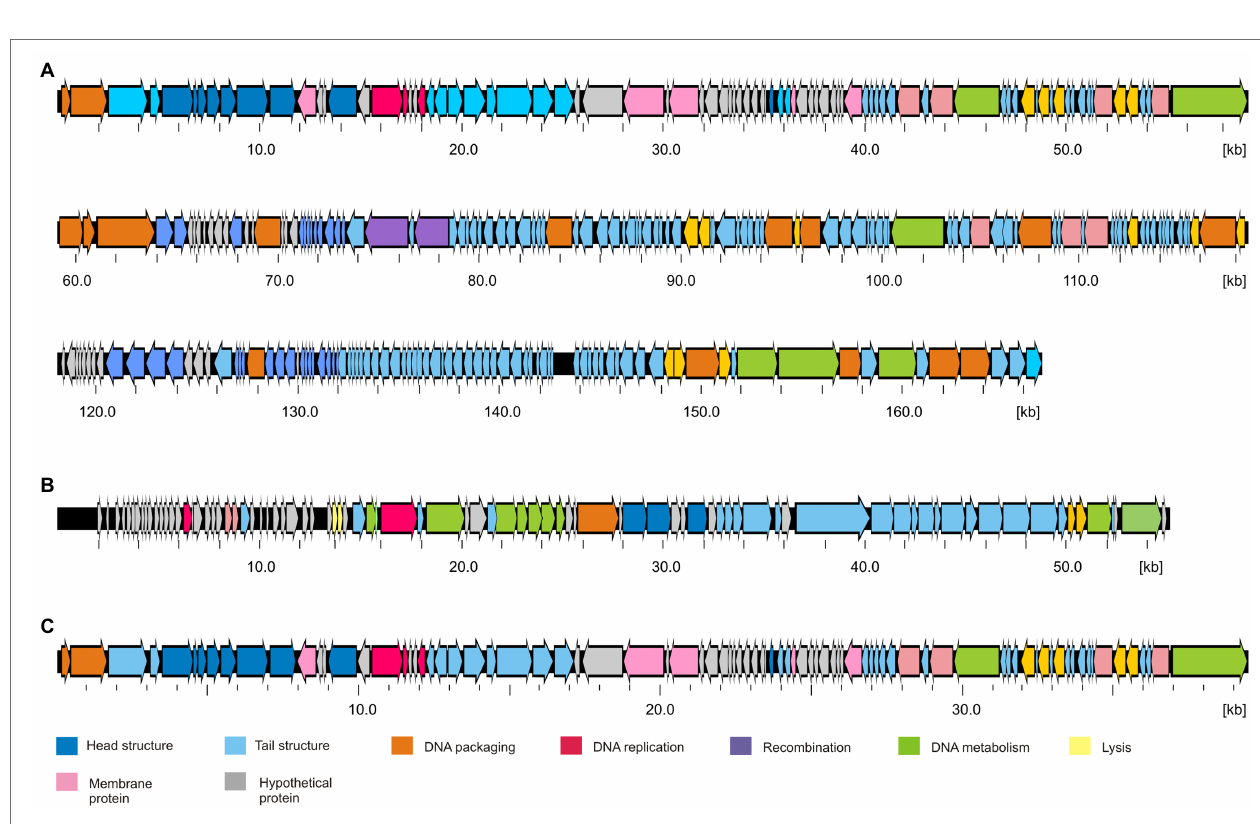
FIGURE 2 | Dot plot analyses of the three Y. pseudotuberculosis type phages with closely related phages. (A) PYps2T, (B) PYps23T, and (C) PYps50T. Dot plot analyses were conducted using Accelrys DS Gene (version 2.5; Accelrys Inc.) with the following settings: minimum sequence identity: 65%; window size: 25; and hash value: 6.